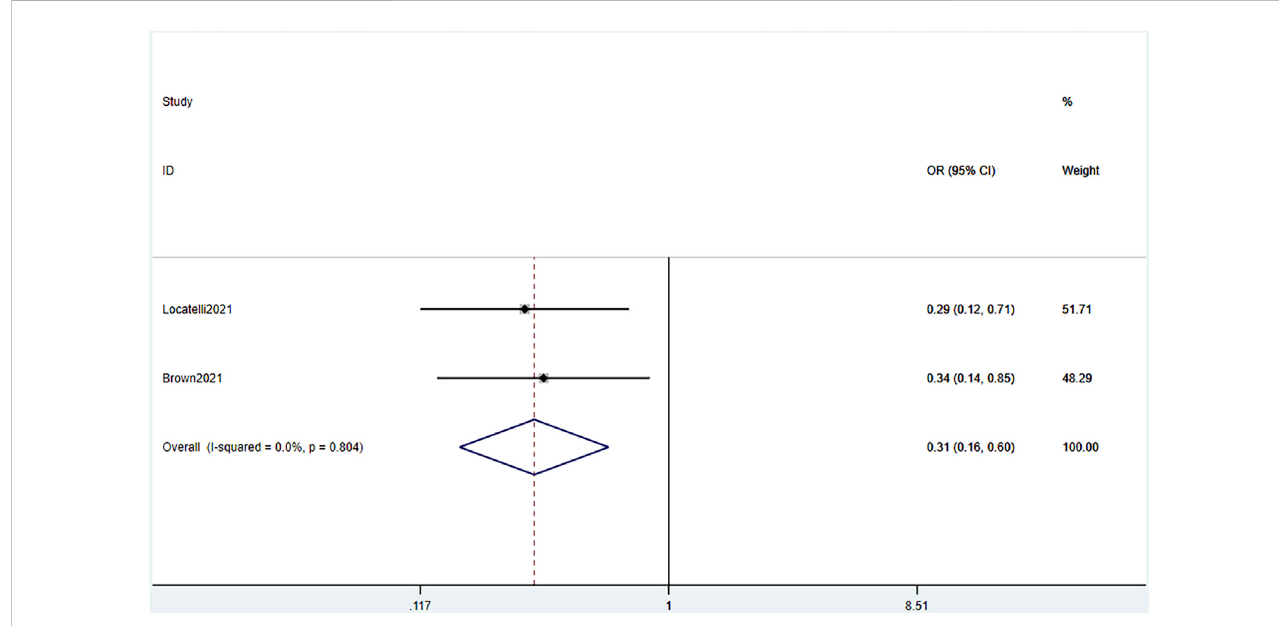
FIGURE 9 Forest plot of AE (RCTs). AE, adverse effects; RCTs, randomized clinical trials; 95% con fi dence interval; OR: odds ratio. The size of the rectangle at the center of the horizontal bar is proportional to the weight of the given study. The diamond at the bottom indicates the pooled OR.